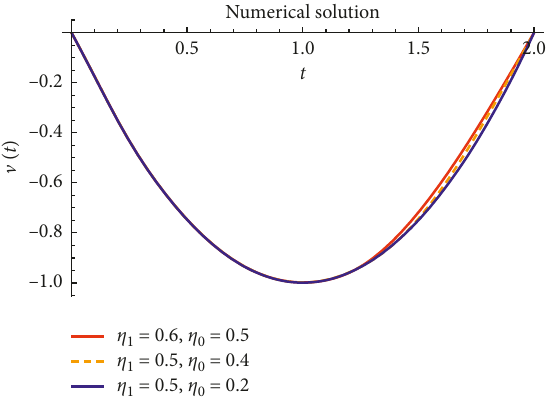
Figure 3: Graph of numerical solution with n � 10 for Example